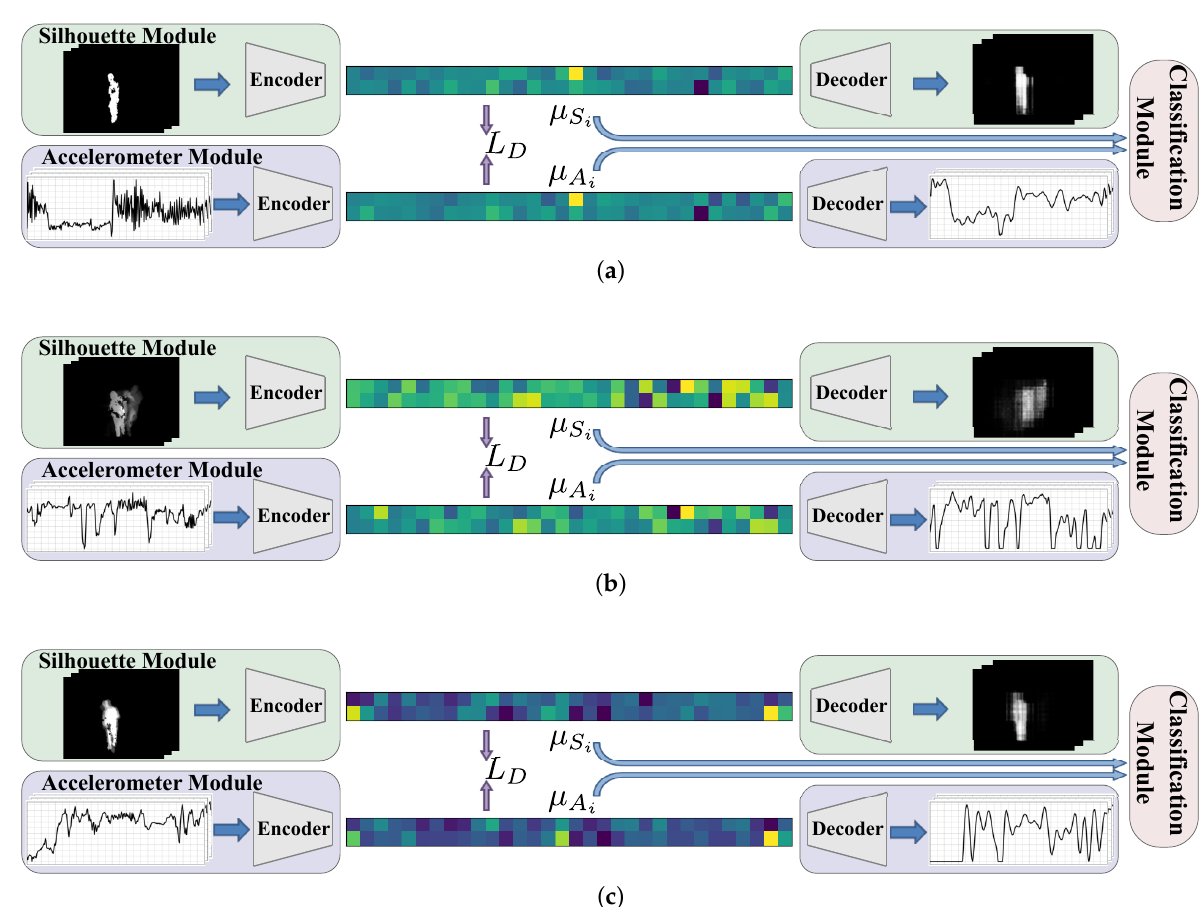
Figure 4. Qualitative results for the similarity between the learnt representations in the two latent spaces, for three examples in ( a – c ), respectively. The first and second rows in each example show the silhouette and accelerometer modules, and the similarity between their extracted features demonstrates the effectiveness of the L D loss.